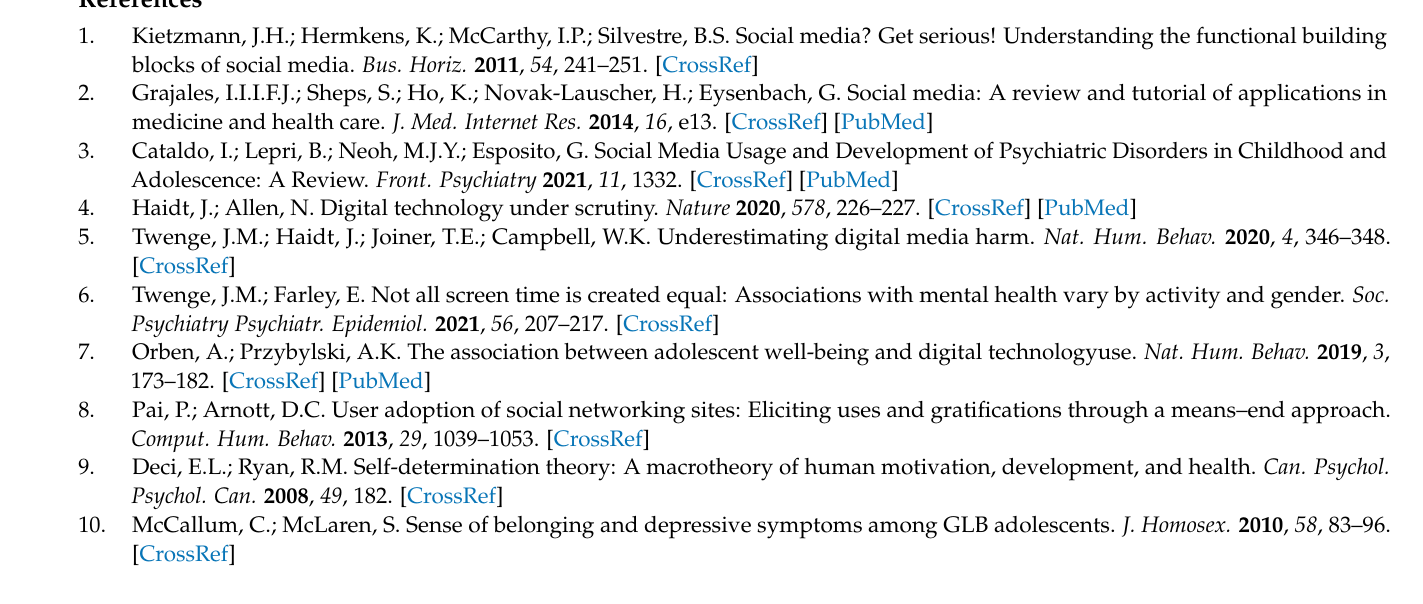
Table S2: The risk of bias for included studies; Figure S1: The sensitivity analyses by omitting the included studies one by one; Figure S2: The metatrim analysis by nonparametric trim-and-fill method. Author Contributions: M.L. contributed to the conception and design, article selection and review, analysis and interpretation of the results, and drafting of the manuscript. K.E.K.-D. contributed